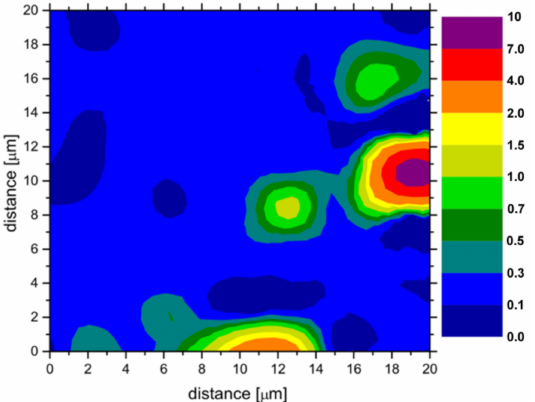
Figure 9. Map of the ratio of the intensity of E 2 (high)–ZnO related peak to A 1g –Al 2 O 3 pertaining